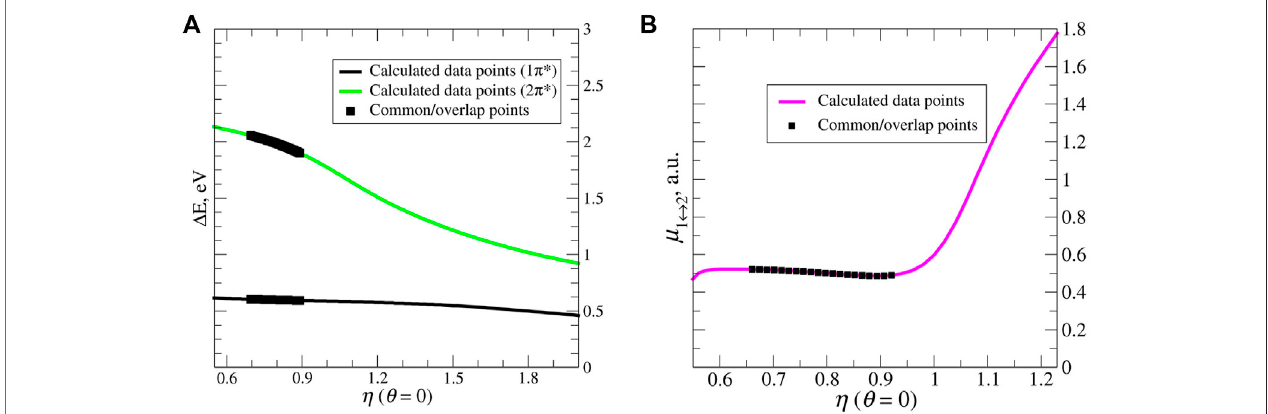
FIGURE14|(A) Stabilization(energy)graphsforthe1 π *and2 π *resonancestatesoftheuracilanion.Theblacksquaresrepresenttheoverlapregion(intheenergy) betweenthetwoelectronicresonancestates. (B) Stabilization(dipoletransitions)graphsfor1 π * ↔ 2 π *.Theblackpointscorrespondstoastablepartonthegraph,which has thesame α -rangeastheoverlap (energy) region.Thesepoints areusedasinputwithinRVP.ThisisnEOM-EA-CCSD/cc-pVTZ+2s2p2d calculation.Reprinted from Ref. [66], with the permission of AIP Publishing.